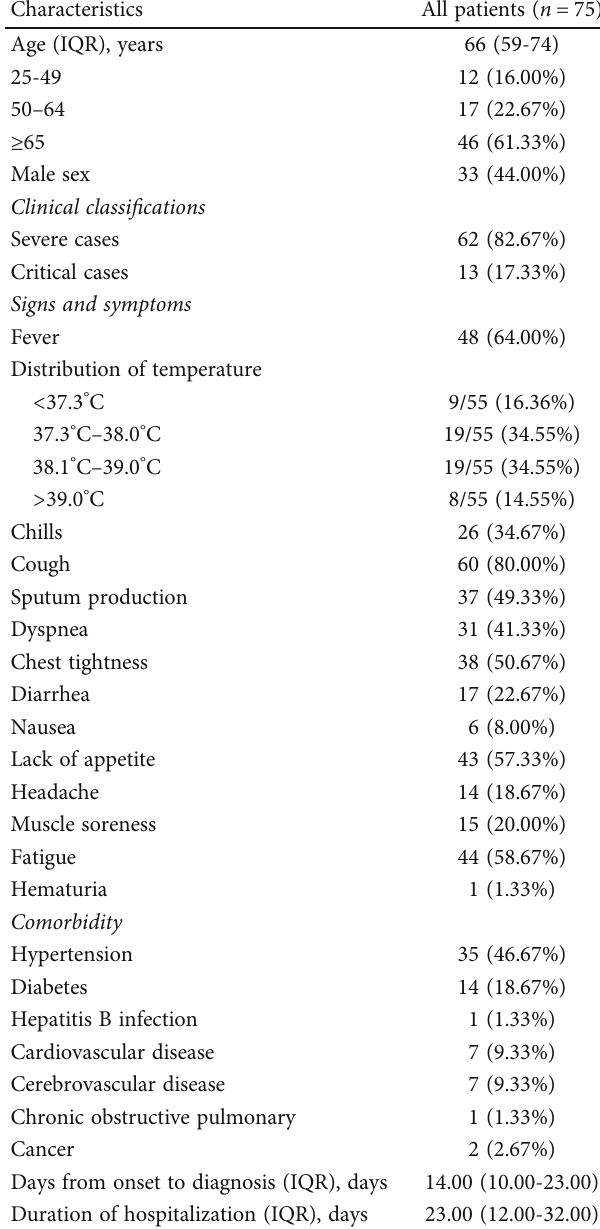
Table 1: Demographic and clinical characteristics of COVID-19 cases upon